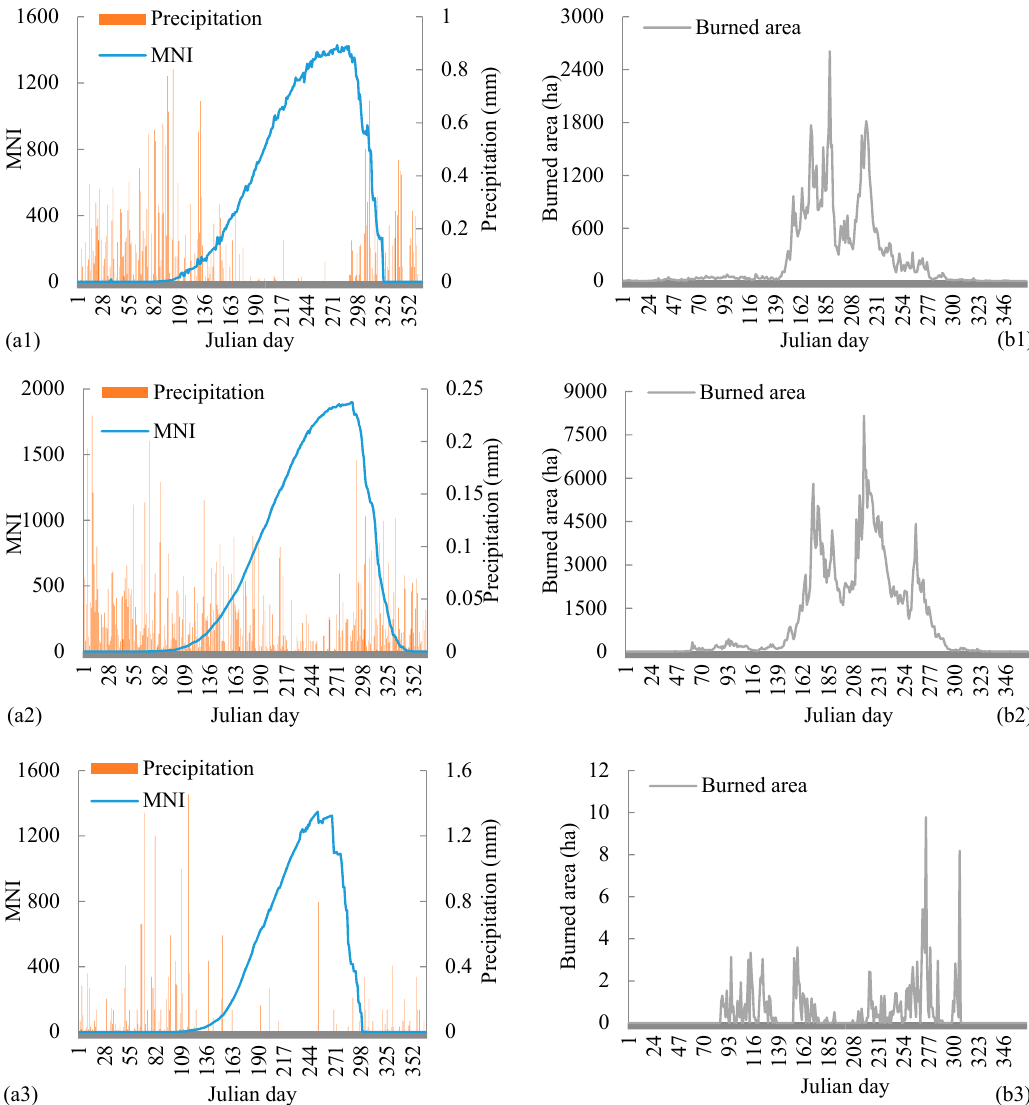
Figure 3. Mean daily modified Nesterov index (MNI), precipitation, and burned areas for the three vegetation zones from 2001–2015. ( a1 ) the mean daily MNI and precipitation for vegetation zones R1; ( a2 ) the mean daily MNI and precipitation for vegetation zones R2; ( a3 ) the mean daily MNI and precipitation for vegetation zones R3; ( b1 ) the mean daily burned areas in R1; ( b2 ) the mean daily burned areas in R2; ( b3 ) the mean daily burned areas in R3.